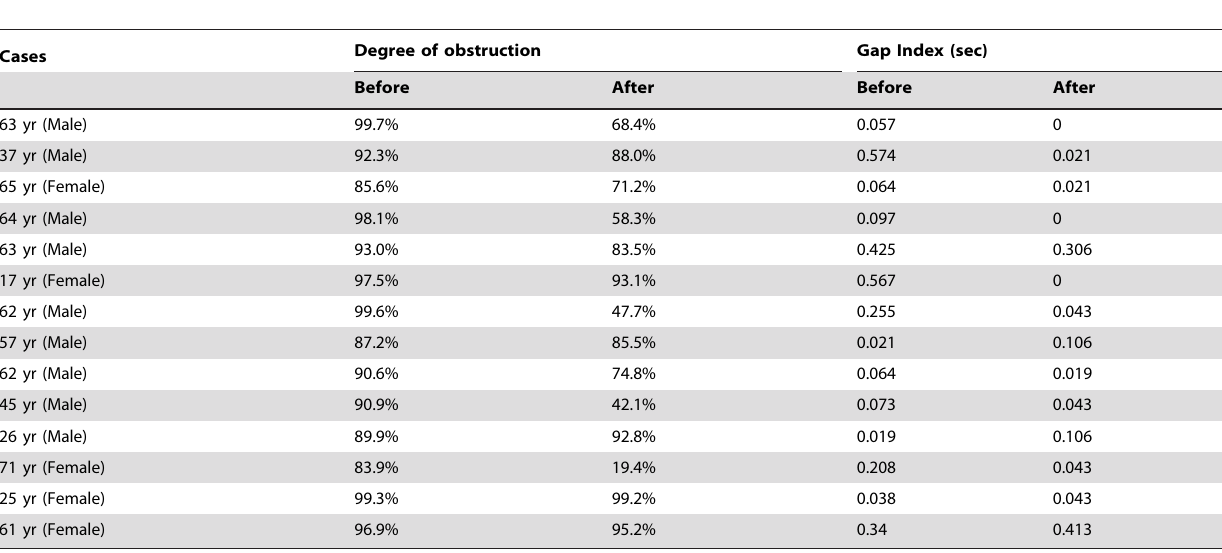
Table 4. The degree of obstruction and Gap index before and after intervention in cases with bronchial obstruction.